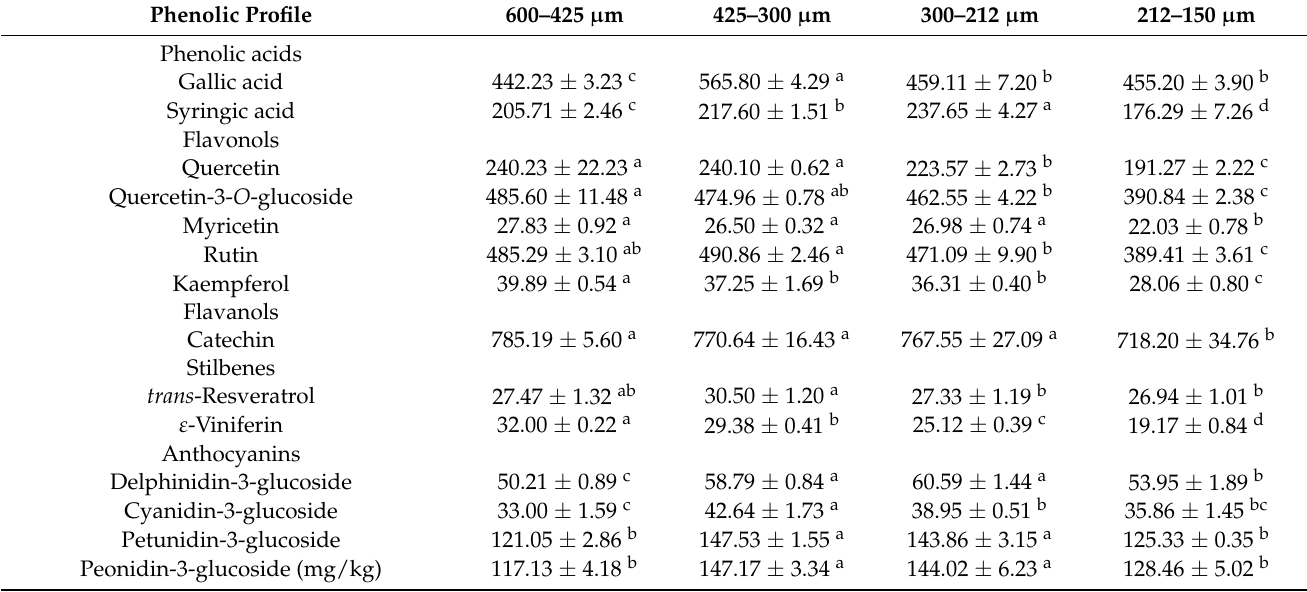
Table 2. Mean values, standard deviation and results of statistical analysis (one-way ANOVA fol- lowed by Tukey’s HSD test for multiple comparison) of single phenolic and anthocyanin compounds determined by HPLC-DAD (expressed as mg/kg of dry matter) of the different grape pomace size